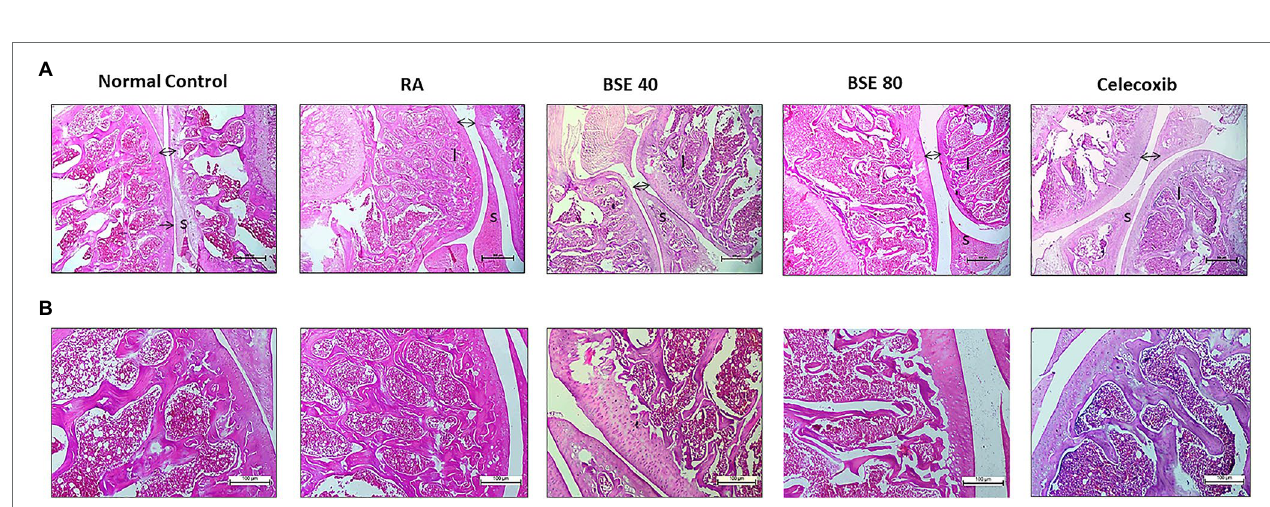
FIGURE 5 | (A) Effect of BSE on arthritis index, (B) paw volume in collagen-induced arthritis. (C) tibiotarsal thickness, (D) dorsiflexion pain, (E) motility score, and (F) stair climbing in collagen-induced arthritis in rats. A standardized method of arthritis scoring was used to evaluate the degree of swelling and erythema of all four paws. The motility pattern, stair climbing, and pain were scored as described in the methods section. ### p < 0.005 compared to control; * p < 0.05 compared to RA animal, BSE 40 and BSE 80, Boswellin Super Extract 40 and 80 mg/kg; CXB, celecoxib 10 mg/kg; and RA, CIA control.